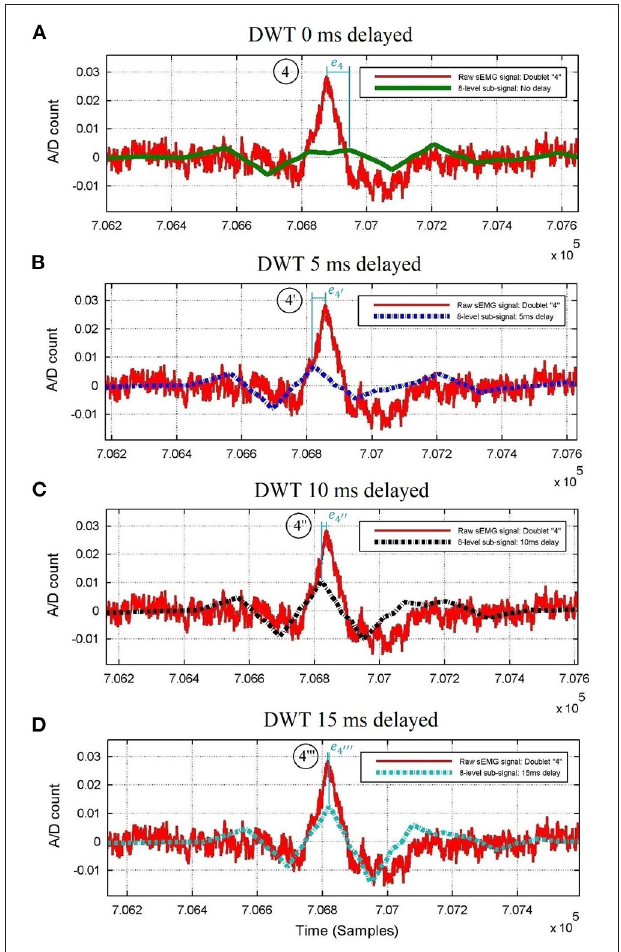
FIGURE 3 | Raw thoracic surface electromyographic signal of control subject #4 centered around doublet #4 of Figure 2 , superimposed with its 8-level wavelet transformed sub-signal when (A) no delay, (B) 5 ms delay, (C) 10 ms delay, and (D) 15 ms delay is applied to the raw sEMG signal before wavelet processing. The peak time errors of the ρ -wave are | e 4 | > | e 4 ′ | > | e 4 ′′ | > | e 4 ′′′ | ; thus, the D8 doublet with the smallest error (#4”’) belongs to the Pareto-optimal front, whereas doublets #4, #4’, and #4” do not.